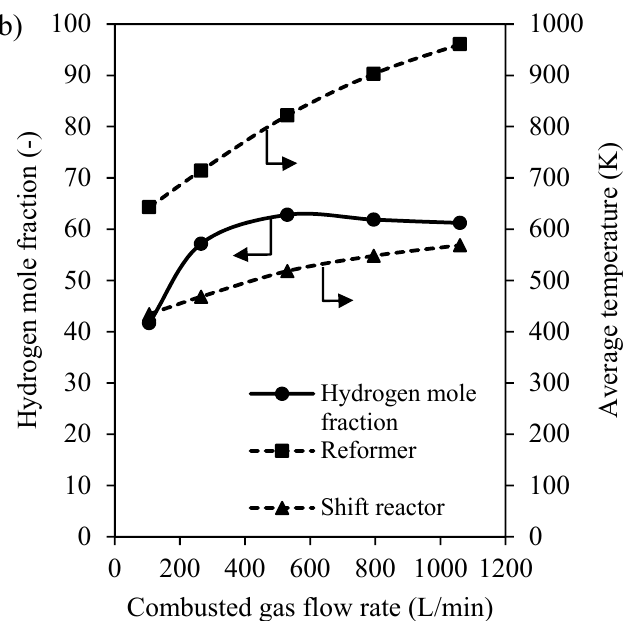
Figure 7. Influence of the ( a ) air preheat and ( b ) combusted gas flow rate on mole fraction of hydrogen and average temperature of the reformer and shift reactor.